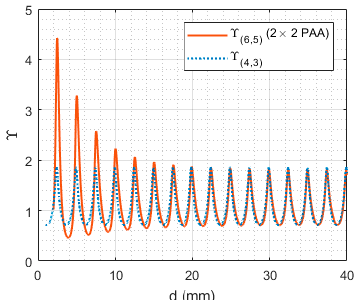
Figure 7. TPD variations due to presence of PEC: Υ ( 4,3 ) and Υ ( 6,5 ) for 2 × 2 PAA equivalent source. Table 3. Average Υ ( 6,5 ) over ∆